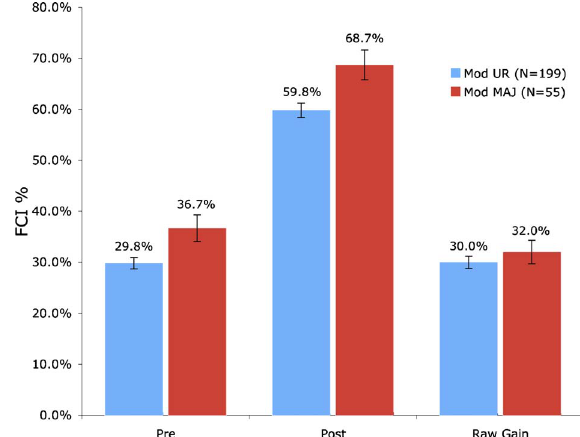
FIG. 4. (cid:1) Color (cid:2) FCI scores in Modeling Instruction disaggre- gated by gender.